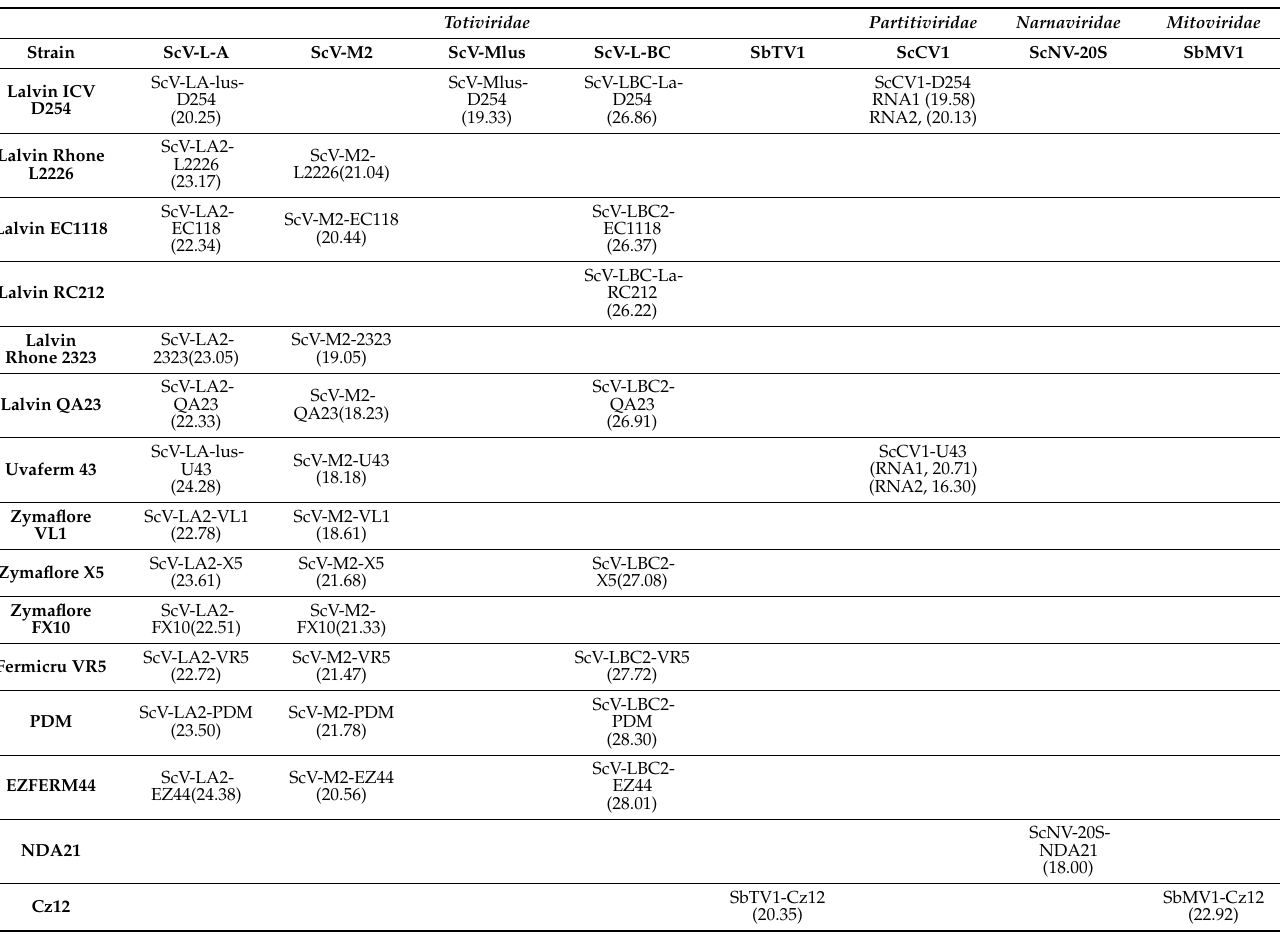
Table 3. List of viral infections detected in the yeast strains. ScV-L-A, Saccharomyces cerevisiae virus L-A; ScV-M2, Saccharomyces cerevisiae virus satellite dsRNA M2; ScV-Mlus, Saccharomyces cerevisiae virus satellite dsRNA Mlus; ScV-L-BC, Saccharomyces cerevisiae virus L-BC; SbTV1, Starmerella bacillaris totivirus 1; ScCV1, Saccharomyces cerevisiae crispovirus 1; ScNV-20S, Saccha- romyces cerevisiae narnavirus 20S; SbMV1, Starmerella bacillaris mitovirus 1. The corresponding threshold cycles of diagnostic real-time PCR on cDNAs are reported in